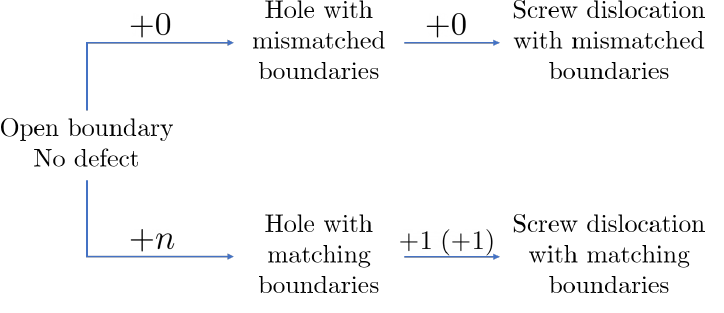
Figure 2: Change of log GSD due to screw dislocation. When boundary condition 2 at the dislocation matches with that on the outer boundary, an edge dislocation / hole introduces extra GSD that increases with the size of the defect ( + n ). Moreover, a screw dislocation can introduce extra GSD due to the tunneling of planon quasi- particles around the screw dislocation as it connects the foliation layers in the system (the + 1 part) and the tunneling of fracton or lineon quasi-particle along the screw dislocation: the (+ 1 ) part. The latter depends on the size of the defect line. When the boundary conditions do not match, there is no change in GSD: +